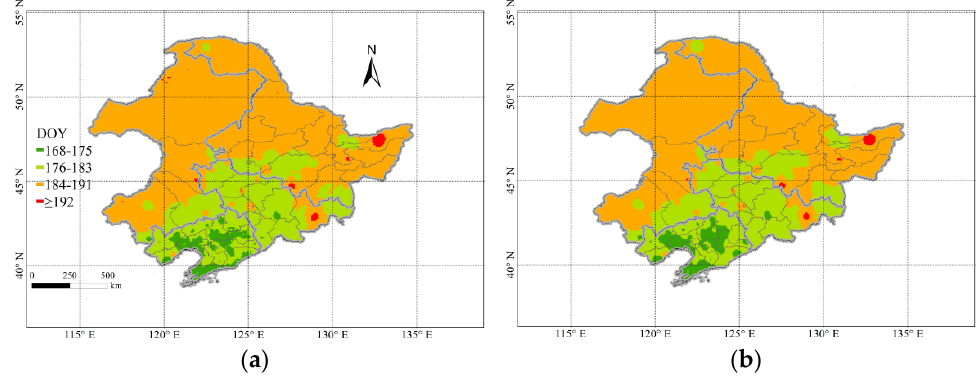
Figure 7. Maize jointing stage (JT) in Northeast China (( a ) fusion data; ( b ) original data).